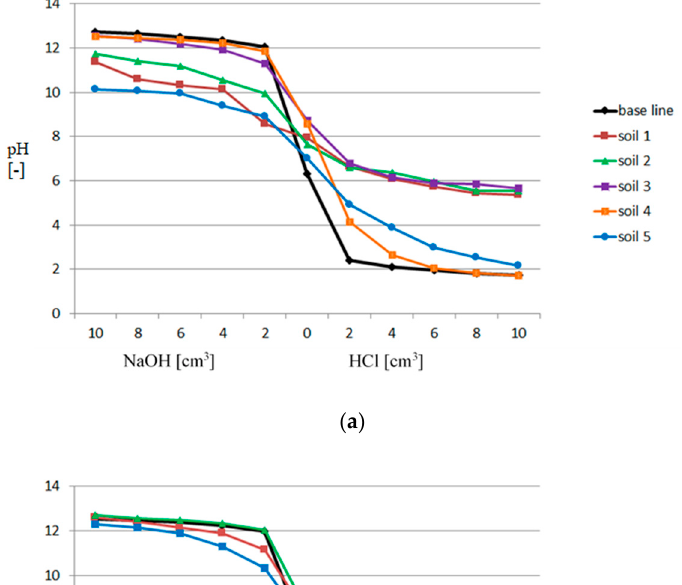
8 of 21 ( c ) Figure 2. Buffer capacity of soil in the Lgota profiles ( a ) Lgota I, soil: 1 (37–52 cm)—loam with